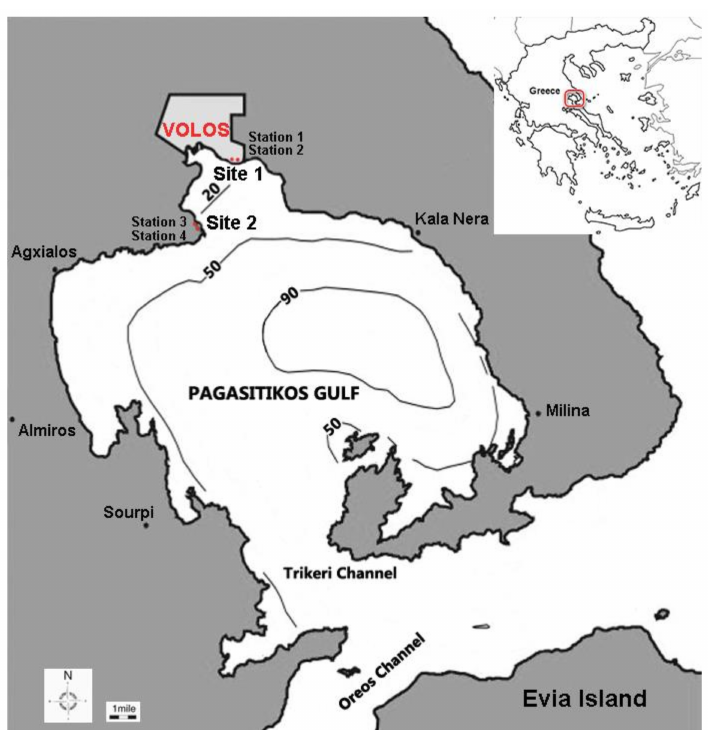
Figure 1. Pagasitikos Gulf depth profile and sample locations, Site 1 (exposed, latitude: 39.347554 and longitude: 22.972509) and Site 2 (sheltered, latitude: 39.297895 and longitude: